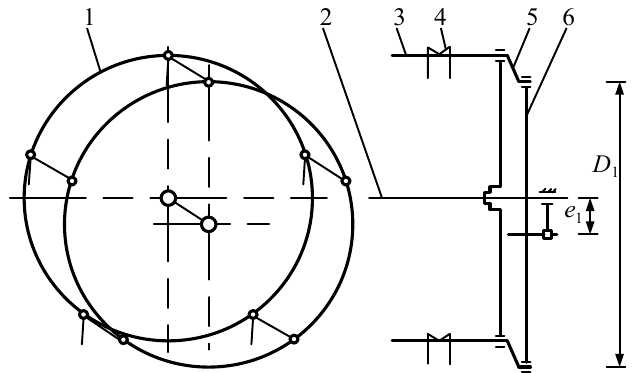
Figure 6. Structural diagram of a cam-action reel. 1. Central spoke wheels; 2. Central rotatable shaft; 3. Tine bar; 4. Tine; 5. Crank; 6. Eccentric spoke